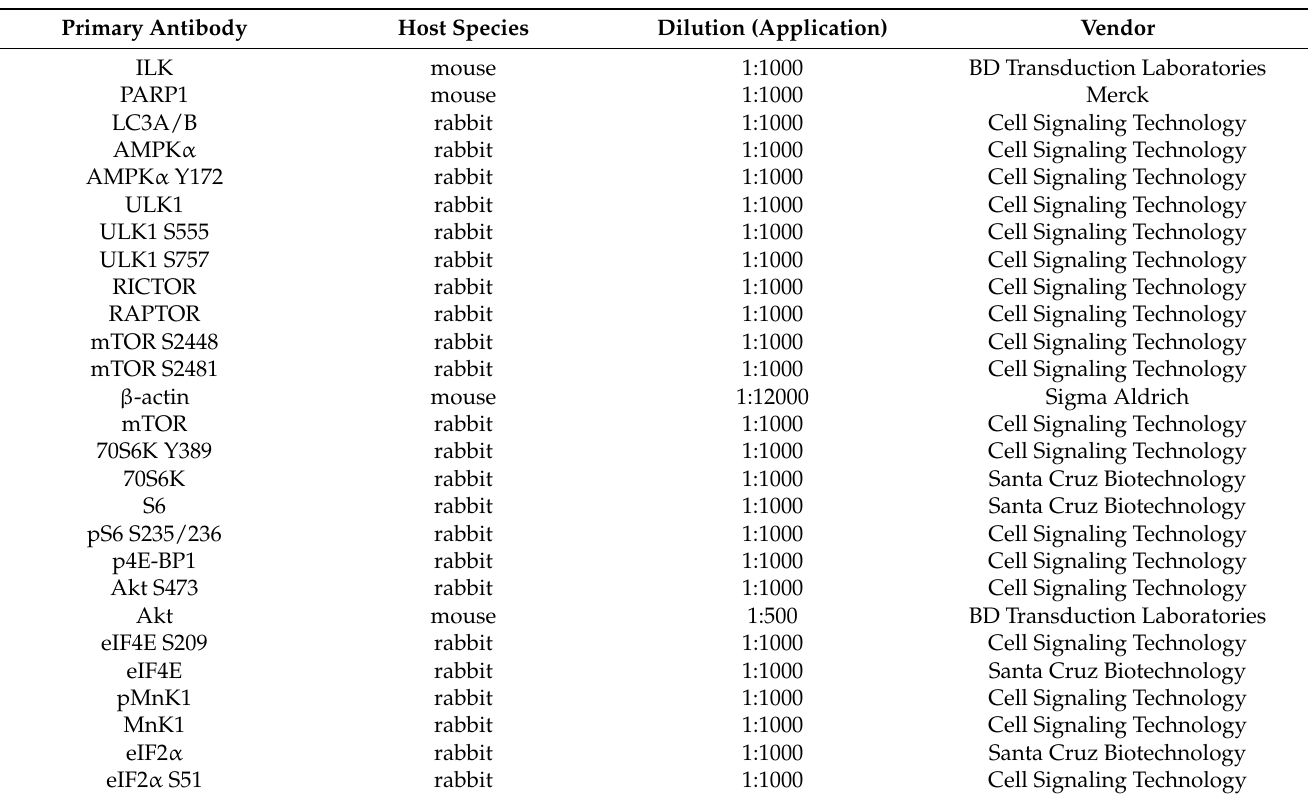
Table 1. Details of primary antibodies used for Western blot